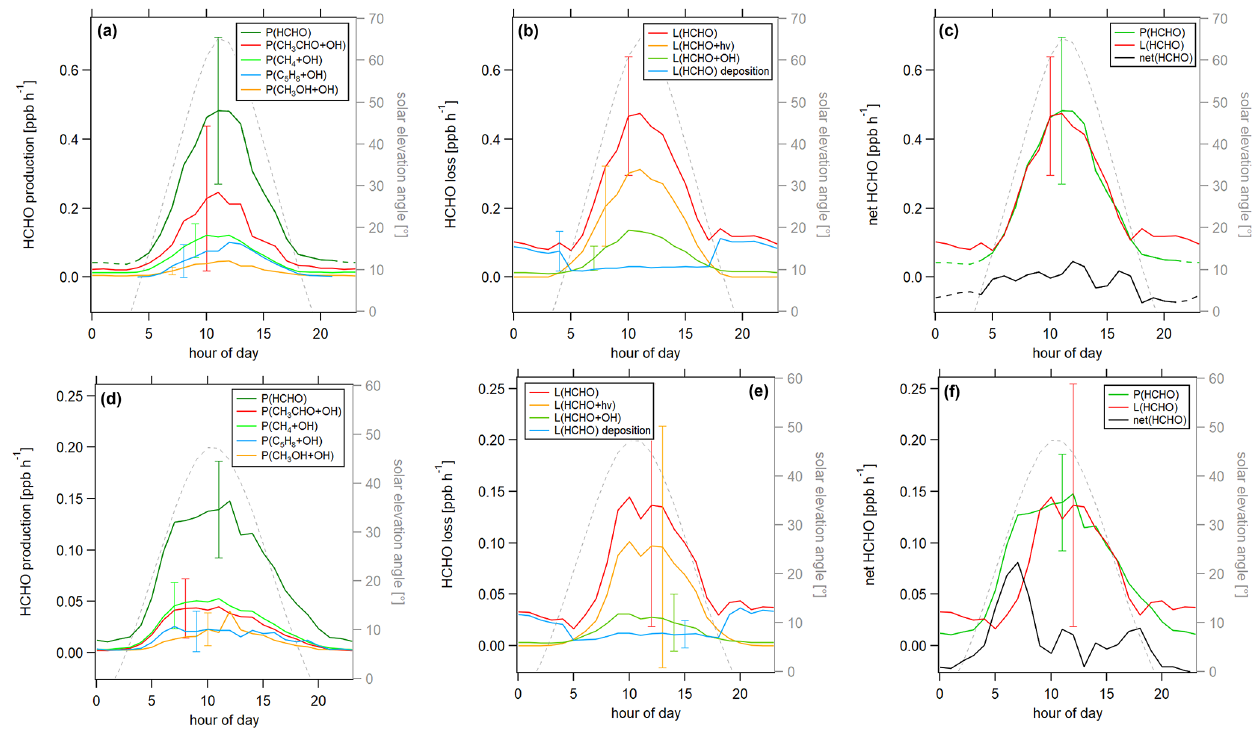
Figure 9. Diurnal profiles of HCHO production P (HCHO) and loss L (HCHO) terms during the HOPE campaign 2012 (top row) and the HUMPPA campaign 2010 (bottom row). (a) P (HCHO), (b) L (HCHO), (c) net HCHO), (d) P (HCHO), (e) L (HCHO) and (f)